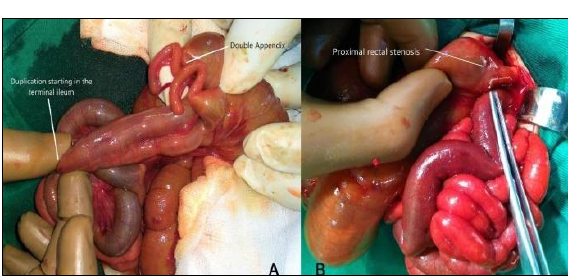
Figure 1: Showing tubular duplication of terminal ileum and colon with double vermiform appendix (A) and distal sigmoid stenosis (B). At surgery, a long tubular Ileo-colonic duplication cyst extending from 15cm proximal to the ileocecal junction (ICJ) to the distal sigmoid colon was encountered, along with double vermiform appendix (Fig. 1A, 1B). Distal sigmoid colon stenosis was noted at the recto- sigmoid junction- where the duplication was just ended. However, the anal canal and distal rectum were patent. The tubular duplication was communicating with the ileum. An end sigmoid colostomy (containing both duplicating segments) was formed with excision of the stenotic segment. The distal rectal stump was closed as Hartmann's pouch. Seromuscular biopsies were taken to exclude HD. Biopsy revealed good ganglion cells without any ectopic tissue. The postoperative course remained uneventful. The baby was discharged on the 8th postoperative